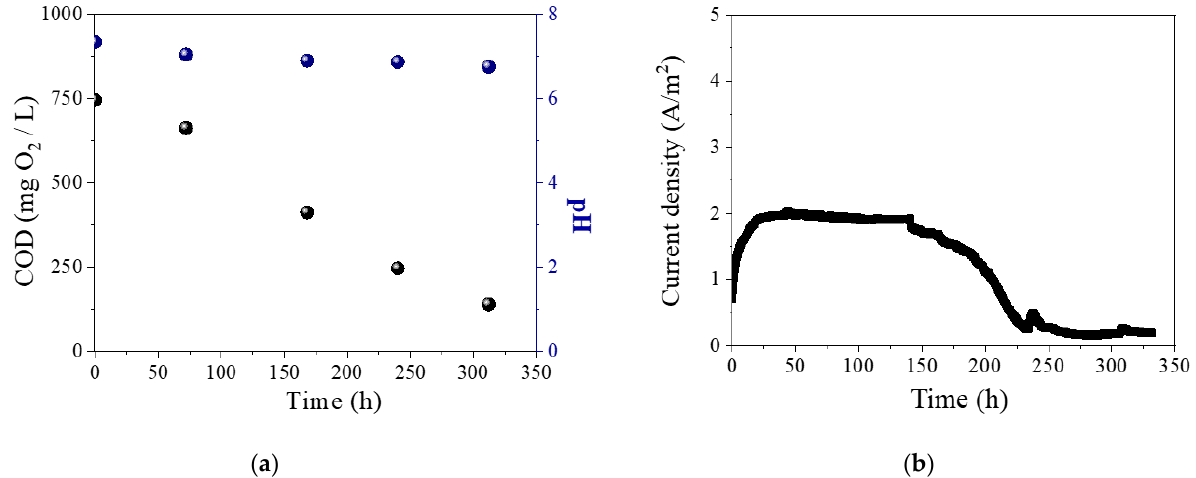
Figure 7. ( a ) COD and pH of the anolyte, and ( b ) current density (normalized to the anodic surface, 2 × 2 cm 2 ) for MEC2 vs. operation time, for the DF effluent feed. Applied cell potential:0.9 V. Table 3. The main characteristics of both MECs for the DF effluent feed.